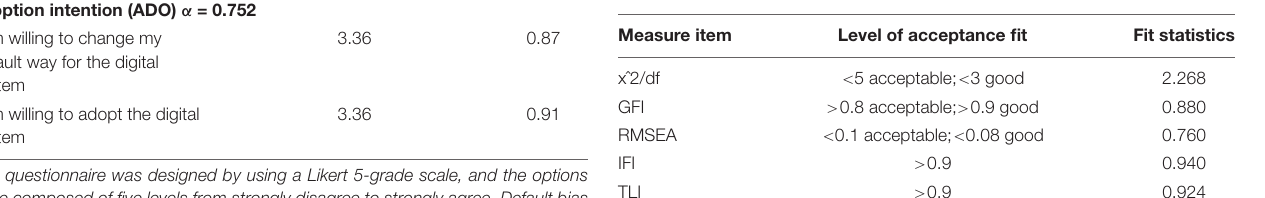
TABLE 5 | Fitness of the structural equation